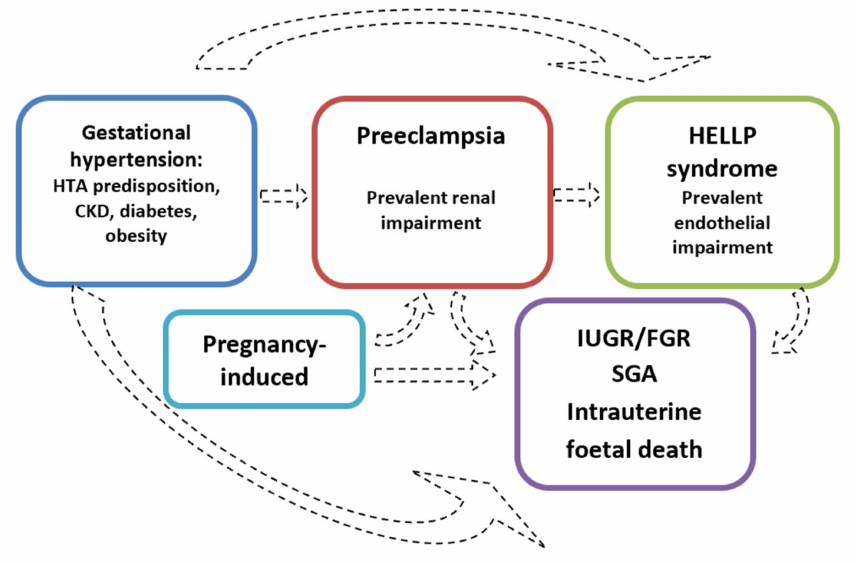
Figure 2. The hypothesis of distinct disorders that may merge into one another. Table 3. Proposed classifications of PE according to severity, time of onset, and